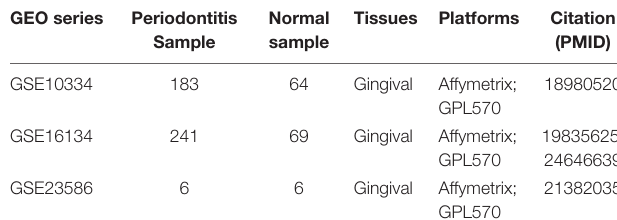
TABLE 1 | Description of microarray profiles in gingival